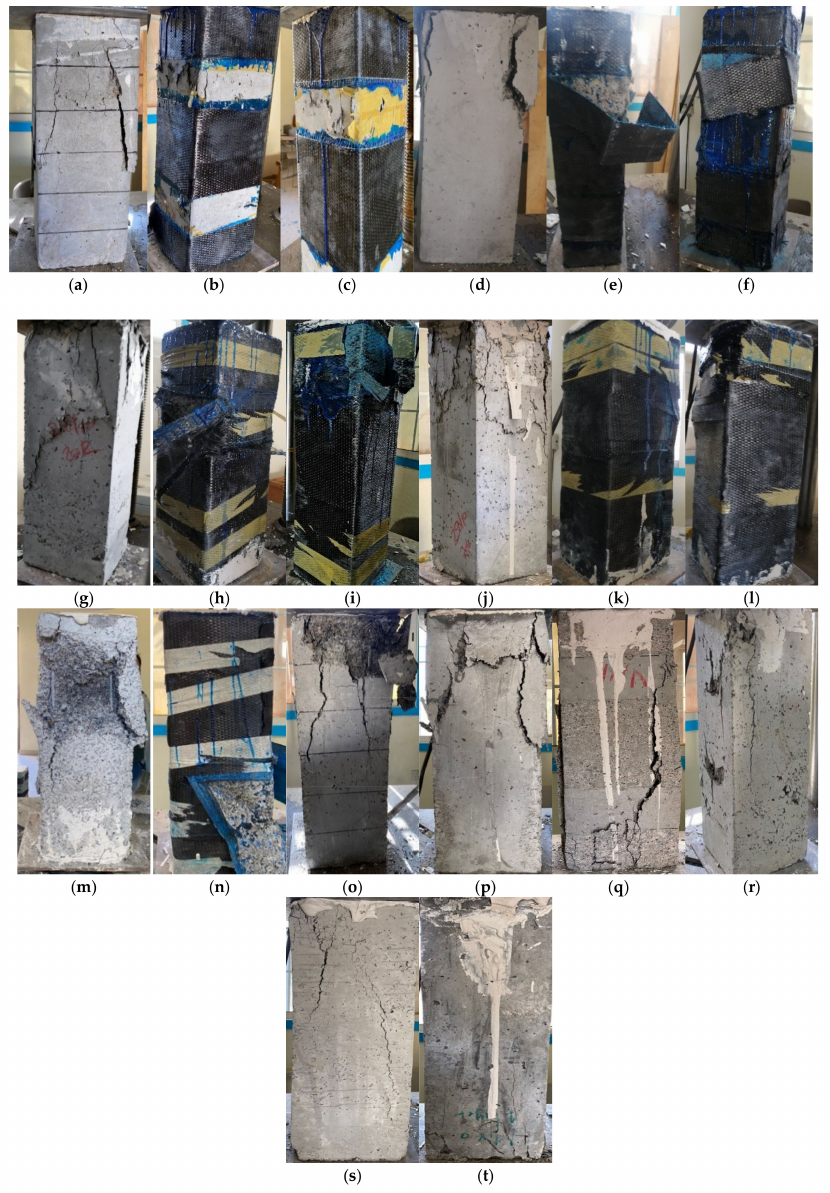
Figure 8. Failure modes of the tested columns. ( a ) R00L0, ( b ) R00L1, ( c ) R00L2, ( d ) R10L0, ( e ) R10L1, ( f ) R10L2, ( g ) R20L0, ( h ) R20L1, ( i ) R20L2, ( j ) R30L0, ( k ) R30L1, ( l ) R30L2, ( m ) R50L0, ( n ) R50L2, ( o ) R10L1w, ( p ) R10L2w, ( q ) R20L1w, ( r ) R20L2w, ( s ) R00L1w, ( t )